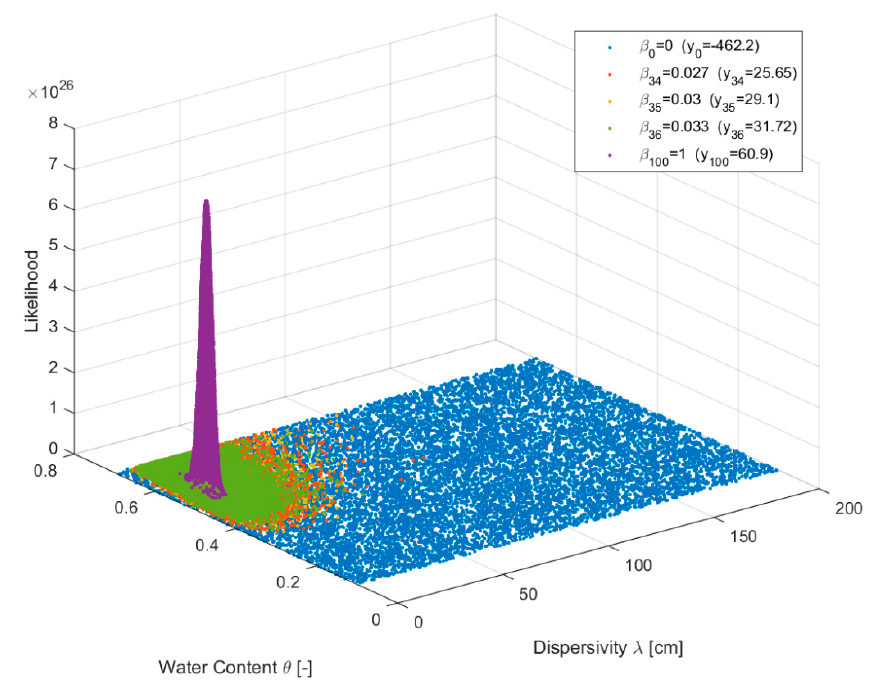
β Figure 2. Likelihood surface at di ff erent β k values of model ADE2. The number of power posterior Figure 2. Likelihood surface at different k values of model ADE2. The number of power posterior coe ffi cients β k are K + 1 with K = 100, and their values are determined by Equation (14) using the shape β + = coefficients k are 1 K with 100 K , and their values are determined by Equation (14) using parameter α = 0.3. We also report the potential expectation y k (Equation (13)) for each α = the shape parameter 0.3 . We also report the potential expectation k y (Equation (13)) for each distribution.